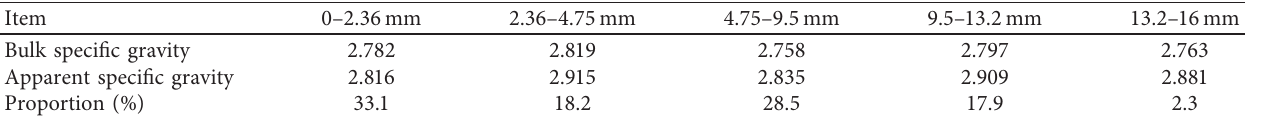
Table 6: Density test results for the different sizes of